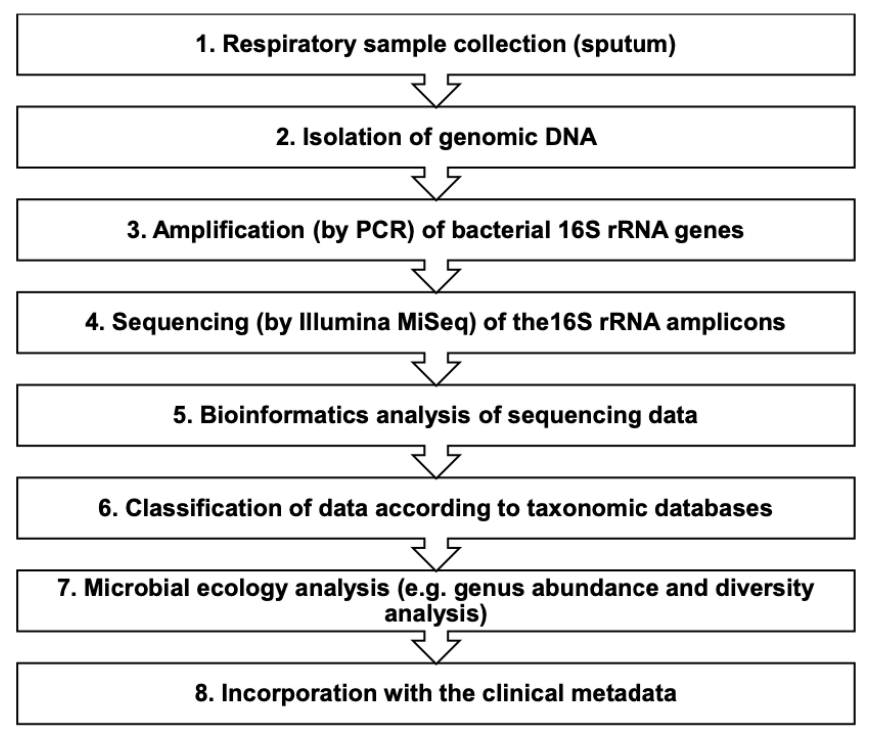
Figure 1. Flow diagram for the microbiome analysis of respiratory specimens (sputa). PCR: poly- merase chain reaction; rRNA: ribosomal ribonucleic acid.